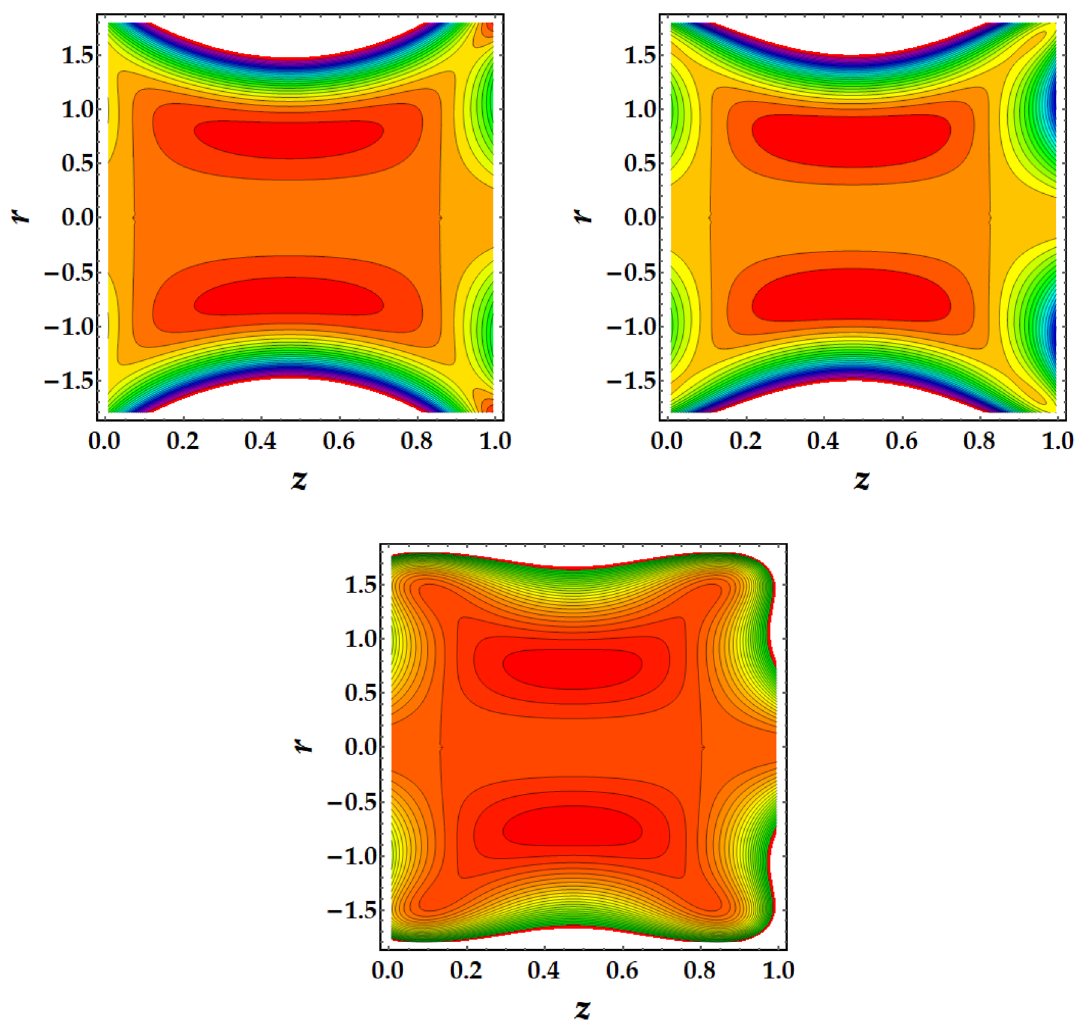
Figure 7. Behavior of streamlines against distinct values of ( a ) ζ = 0 , ( b ) ζ = 1 , ( c ) ζ = 2